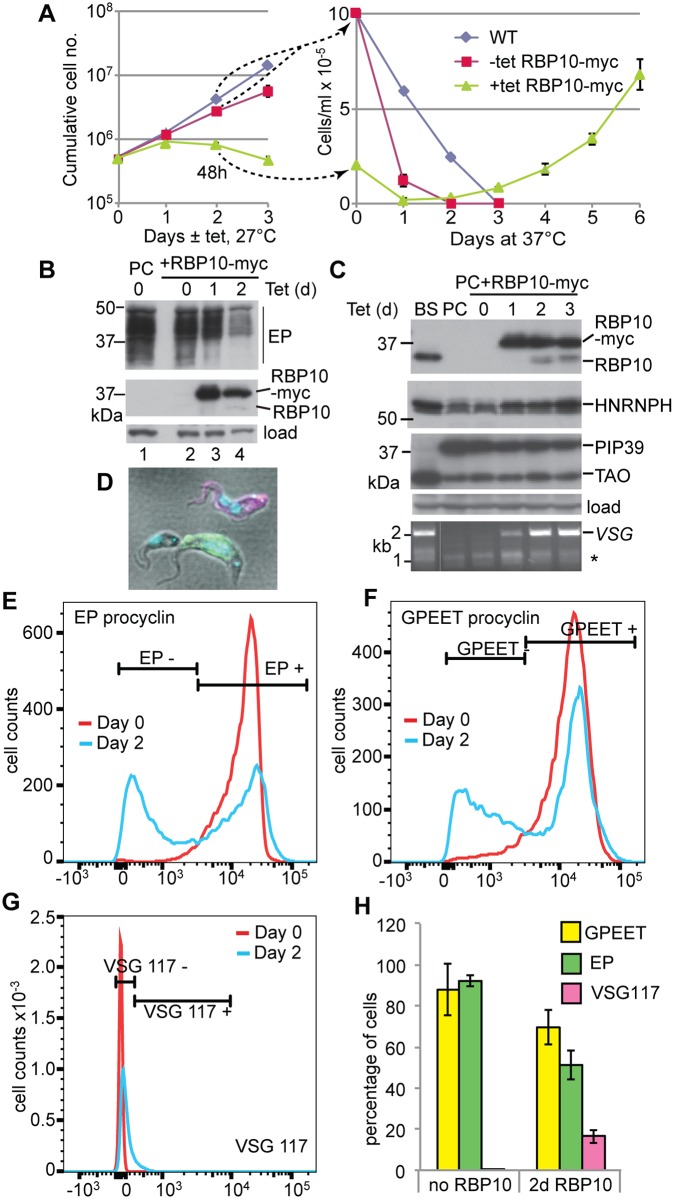
RBP10 expression in procyclic forms causes differentiation to bloodstream forms.A) Cell counts in a typical experiment. Expression of RBP10-myc was induced using tetracycline at 27°C in procyclic-form medium. The left-hand panel is a cumulative growth curve. After 48h cells were transferred to bloodstream-form medium at 37°C; in the right-hand panel cell densities are shown. B) Expression of EP procyclin and RBP10 after induction of RBP10-myc expression. Cells were cultured in procyclic medium at 27°C. Expression of EP procyclin protein decreased after 48h of RBP10-myc induction, while untagged RBP10 becomes detectable. C) As in (B) except that culture continued for 3 days. Proteins that are expressed more in bloodstream forms than in procyclic forms were detected by Western blotting. TAO is trypanosome alternative oxidase; HNRNPH is an RNA-binding protein. VSG mRNA was detected by RT-PCR using a spliced leader primer and a primer that hybridizes to a conserved region within the VSG 3'-UTR. D) Trypanosomes were taken after 48h RBP10-myc induction. They were stained for EP procyclin and phosphorylated GPEET procyclin (green), VSG117 (magenta) and DNA (cyan). The stain is overlaid with differential interference contrast (grey). The panel shows a typical green procyclic form, a bloodstream form with two kinetoplasts, and a third cell which resembles a bloodstream form (terminal kinetoplast) but was not stained by anti-VSG117. This cell may express a VSG that does not react with the anti-VSG117 antibodies. E) Quantitation of surface EP procyclin by flow cytometry, comparing cells with (day 2) and without (day 0) induced RBP10-myc expression. F) Quantitation of surface phospho-GPEET procyclin by flow cytometry, comparing cells with (day 2) and without (day 0) induced RBP10-myc expression. G) Quantitation of staining with anti-VSG117 by flow cytometry, comparing cells with (day 2) and without (day 0) induced RBP10-myc expression. H) Measurement of surface protein expression by flow cytometry. Values for the different windows are mean and standard deviation from 4 replicates. Similar results were obtained by manual counting of stained smears (S8 Fig).